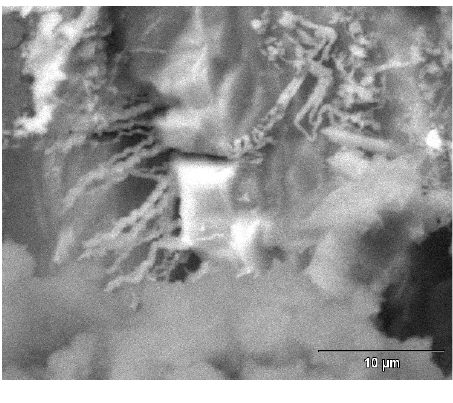
Figure 16. The micron-size filaments inside the crystallographic gaps (not fixed in